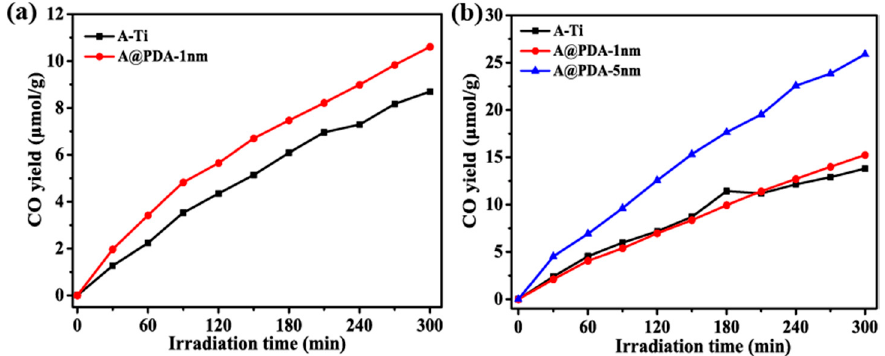
Figure 2. The comparison of CO yield for A-Ti and A@PDA-1 nm under visible light ( a ) and for the A-Ti, A@PDA-1 nm, and A@PDA-5 nm under UV-vis light ( b ) in CO 2 .